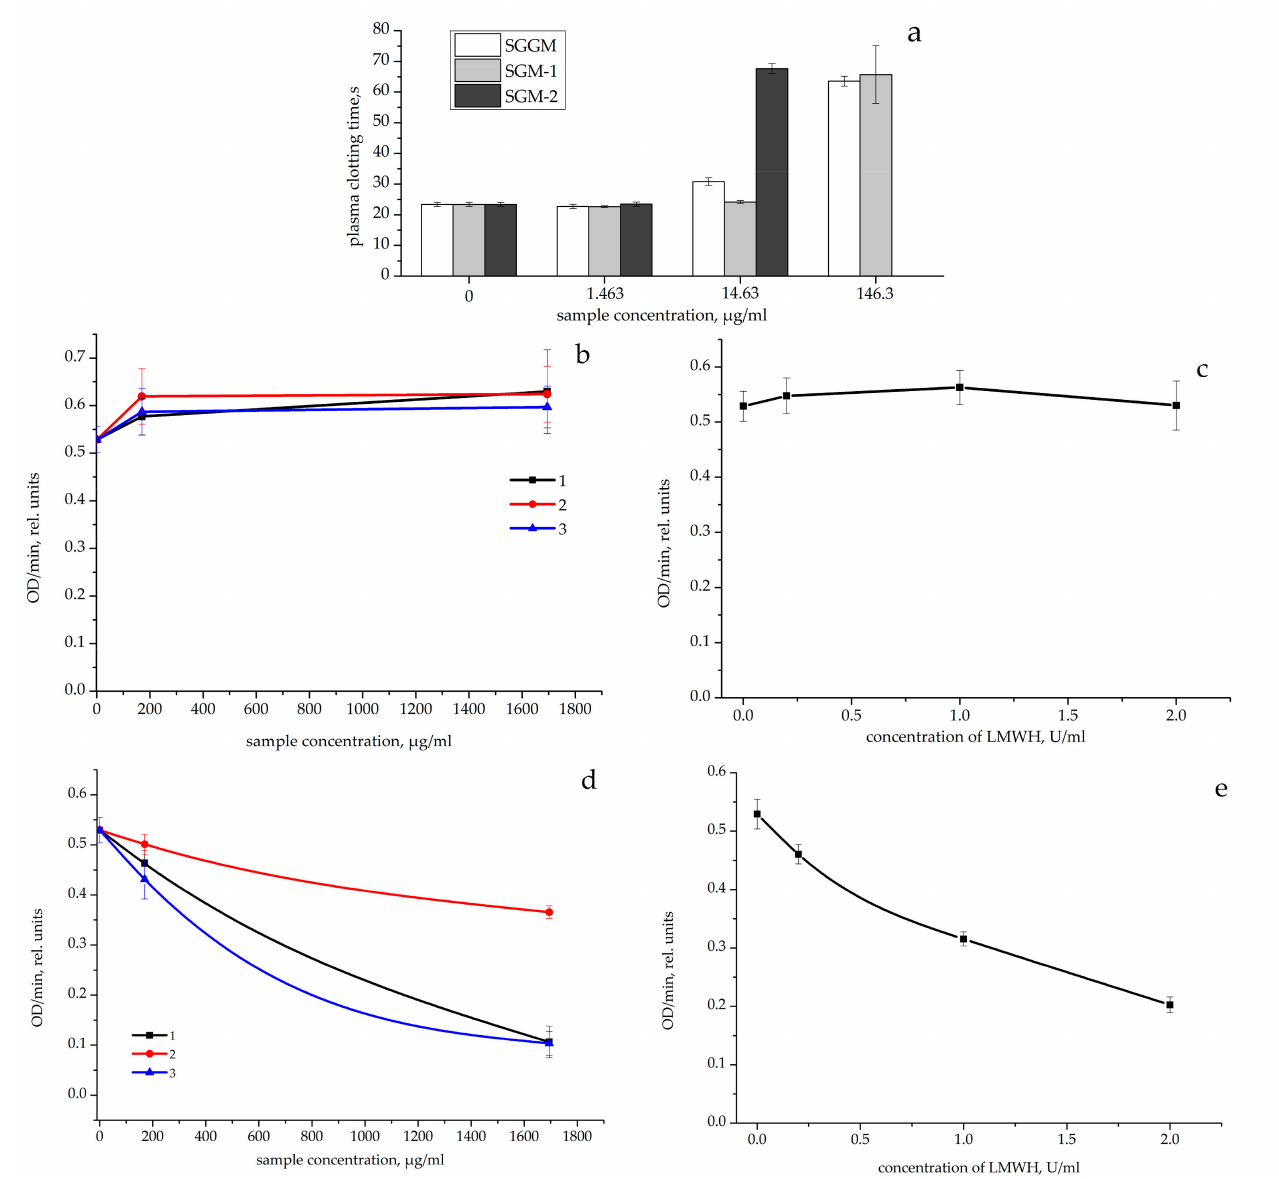
Figure 4. Effect of the GGM/GM sulfates on the plasma clotting time (s) in the ReaClot-Heparin test ( a ) ( n = 6). Effect of ( b , d ) the GGM/GM sulfates and ( c , e ) LMWH on the optical density variation (OD/min, rel. units) in the solution containing factor Xa, the chromogenic substrate ( b , c ; n = 6) or factor Xa, the antithrombin, chromogenic substrate ( d , e ; n = 6). (1) SGGM, (2) SGM-1, and (3) SGM-2. The factor Xa incubation with AT and the SGGM/SGM samples (169.44 and 1694.4 µ g/mL) reduced the rate of hydrolysis of the chromogenic substrate for factor Xa compared with the control (A405/min in the control 0.5293 ± 0.0256 rel. units, Figure 4d). The SGGM, SGM-1, and SGM-2 concentrations [A405/min:2] attained 991.7 ± 89.1, 2500 ± 174.1, and 876.7 ± 137.6 µ g/mL, respectively. The growth of the LMWH concentration in the incuba- tion mixture with factor Xa and AT led to a decrease in the reaction rate (Figure 4e) and the concentration [A405/min:2] was 1.358 ± 0.1051 U/mL. Thus, the SGGM/SGM samples alone did not affect the amidolytic activity of factor Xa. The concentrations [A405/min:2] of the SGGM and SGM-2 samples in the reaction with AT did not differ, although the aXa activity of SGM-2 was higher by a factor of